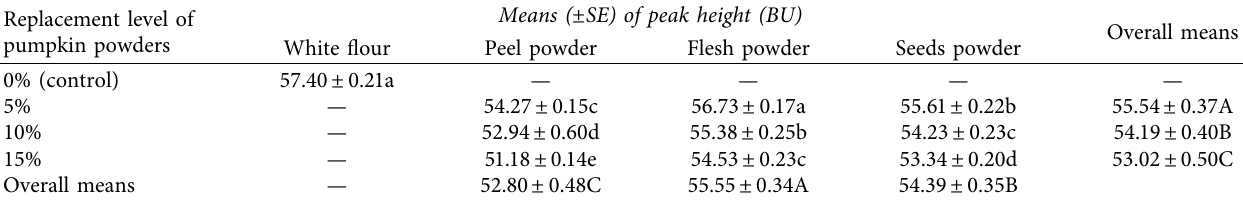
Table 6: Peak height (BU) of biscuits with diferent replacement levels of pumpkin peel, fesh, and seed powders. Means ( ± SE) of peak height (BU) Replacement level of pumpkin powders